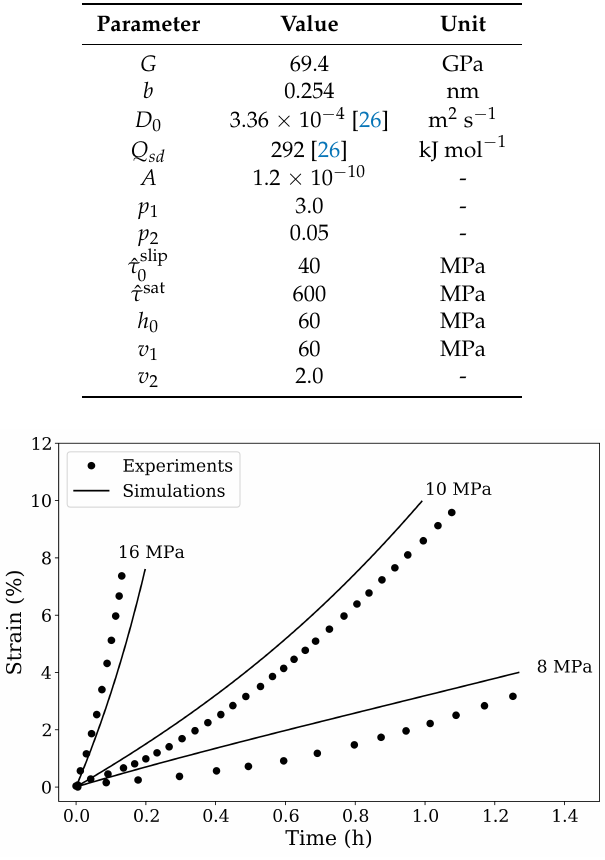
Table 1. Fitted material parameters for CMSX-4 superalloy. ˆ τ slip by dislocation interaction.